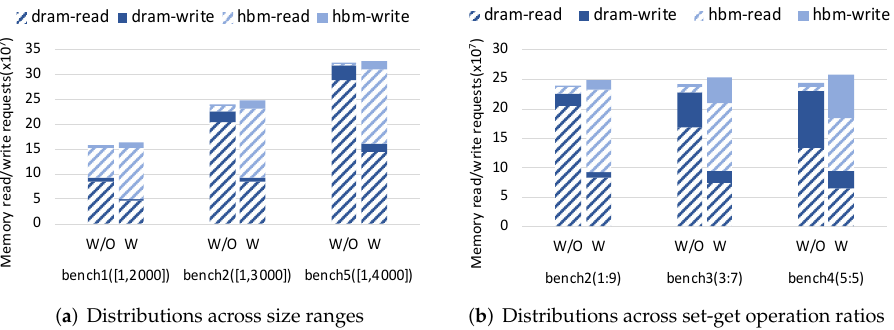
Figure 8. Distributions of dram/hbm read/write requests across different size ranges and set-get operation ratios.